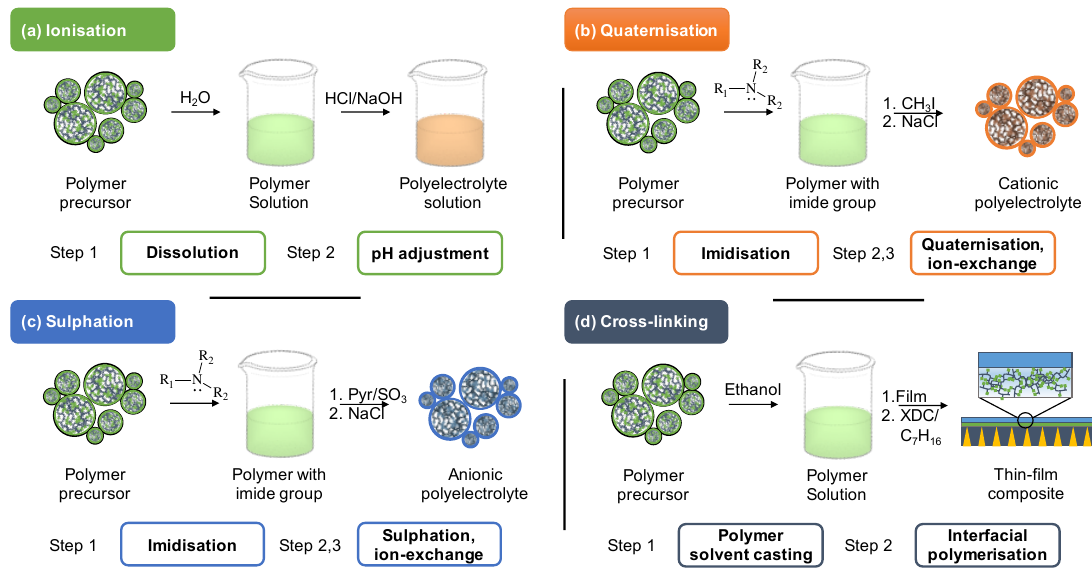
Figure 5. Major approaches for post-synthetic modification of polymer to produce ‘top-down’ polyelectrolytes include ( a ) ionisation, ( b ) quaternisation, ( c ) sulphation, ( d ) cross-linking. XDC abbreviates p-Xylylene